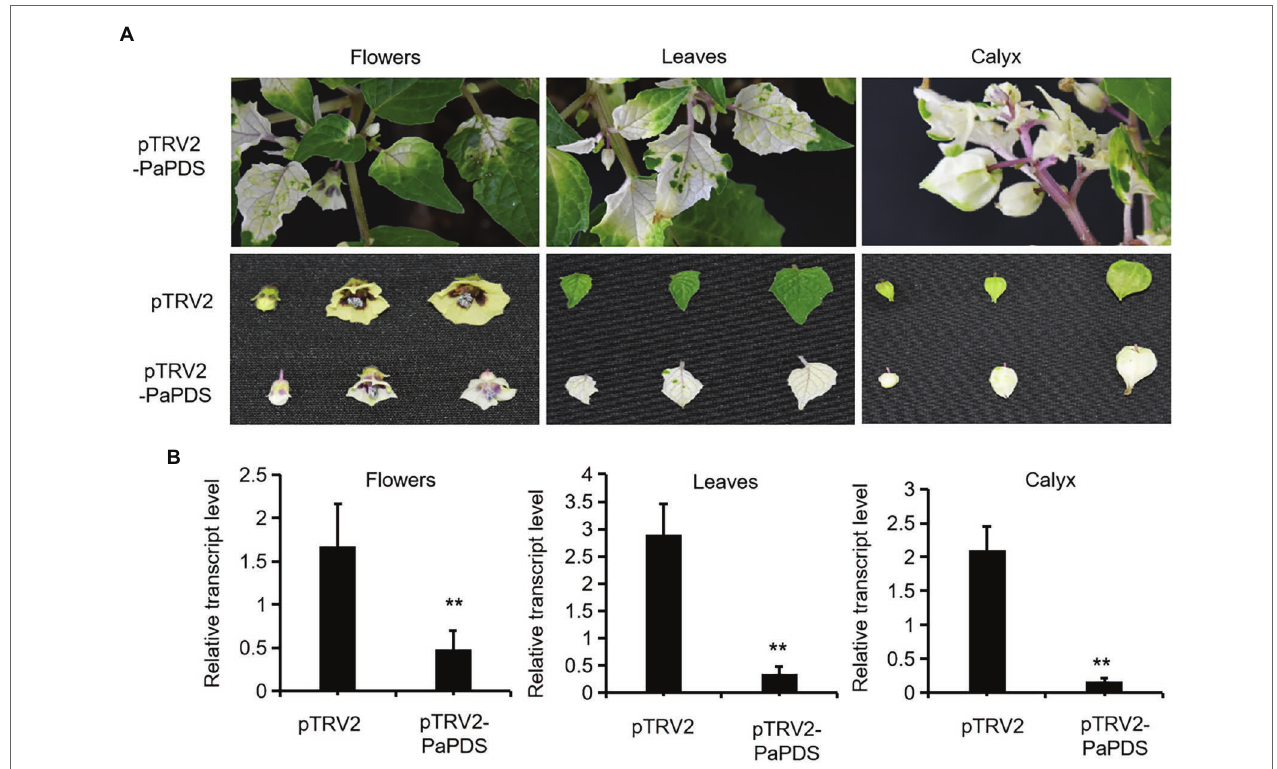
FIGURE 4 | Silencing of PaPDS in P. angulata using the TRV2-based VIGS. (A) Representative photobleaching phenotype of flower, leaf and calyx tissues from the PaPDS -silenced plants. The upper row shows the intact PaPDS -silenced plants, and the below row shows the detached various tissues from the PaPDS -silenced plants, compared to those from the empty vector-transferred control. (B) qRT-PCR analysis of PaPDS in various tissues of P. angulata inoculated with pTRV2- PaPDS and the empty vector pTRV2. The error bars represent ± SE of three independent experiments (** p ≤ 0.01 by student t